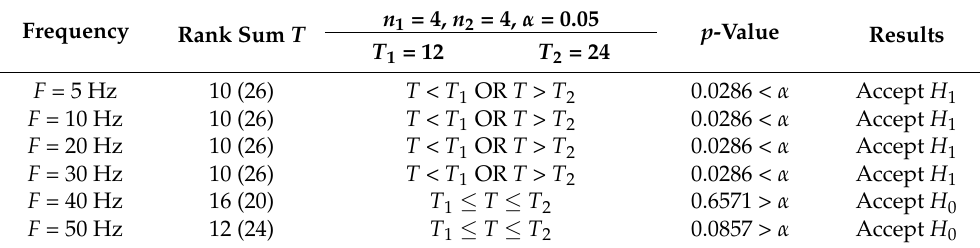
Table 6. Wilcoxon Rank-Sum results.